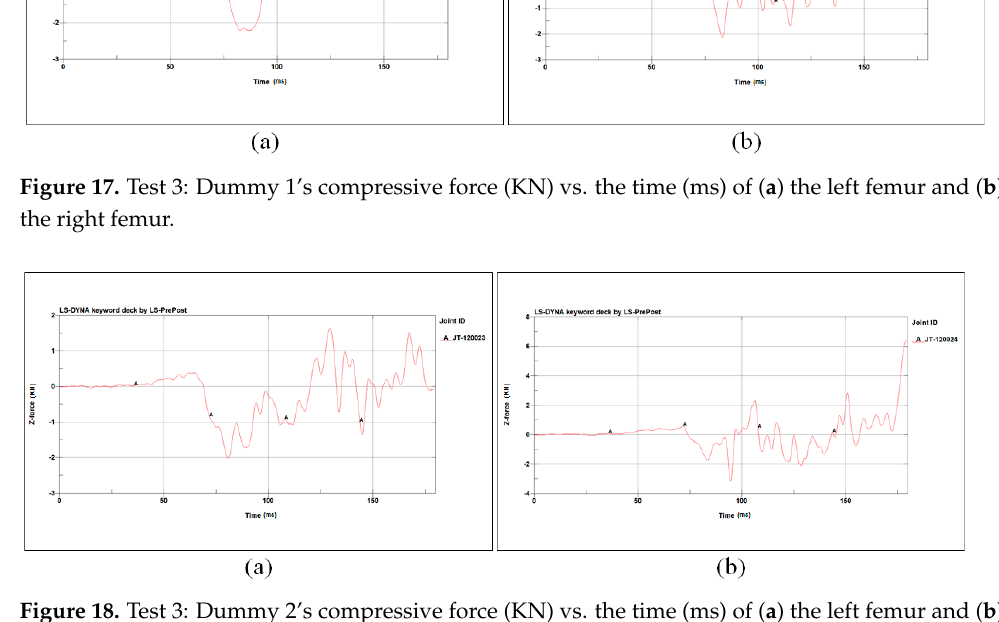
Figure 18. Test 3: Dummy 2 ′ s compressive force (KN) vs. the time (ms) of ( a ) the left femur and ( b ) the right femur.